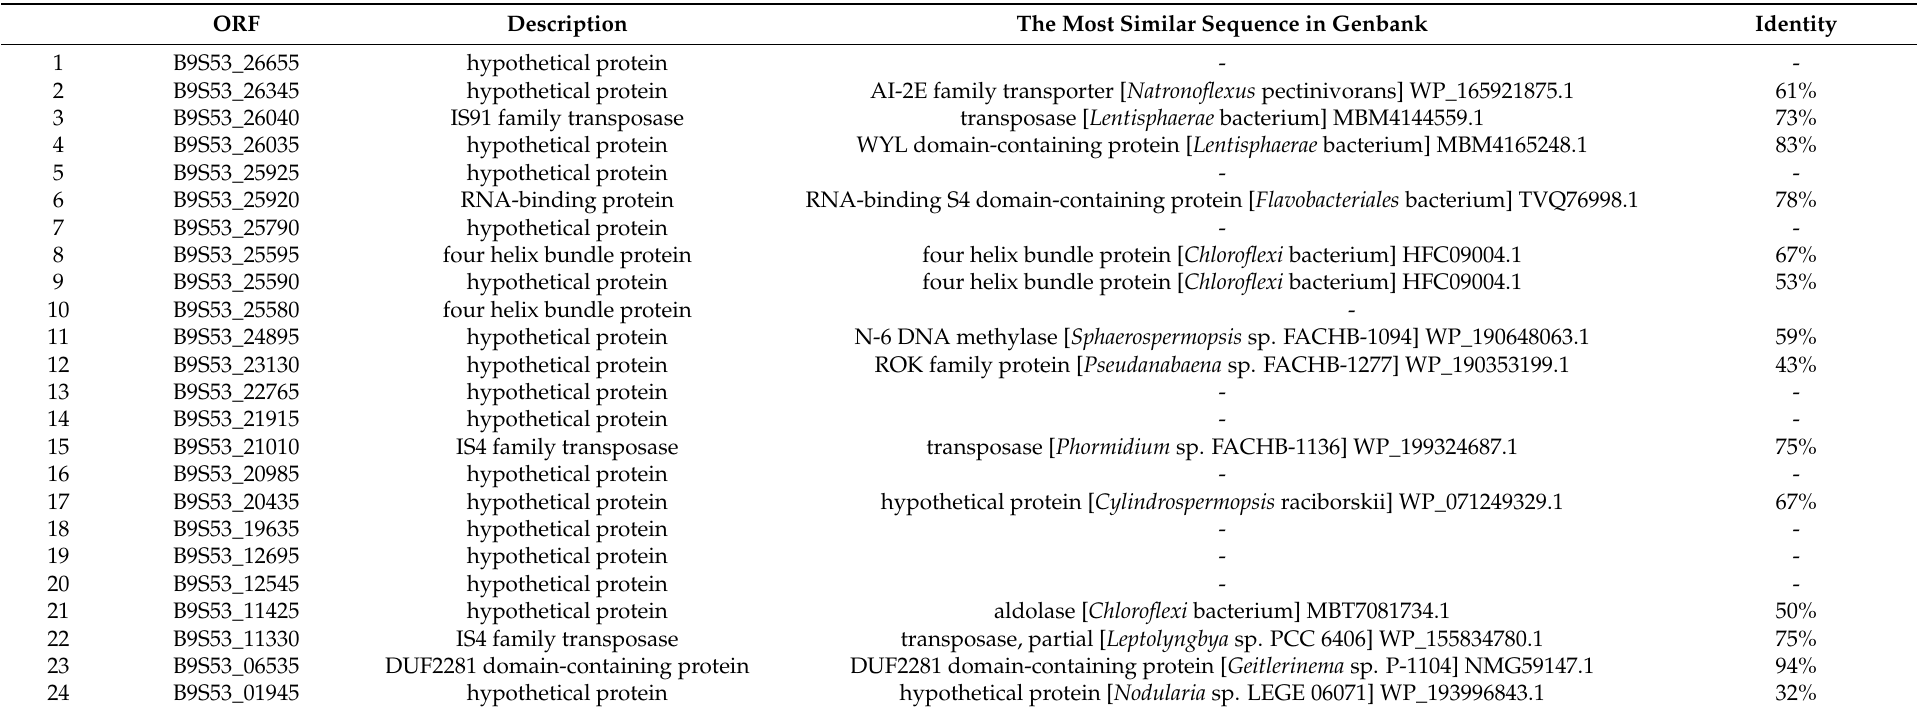
Table 4. Arthrospira sp. O9.13F-specific